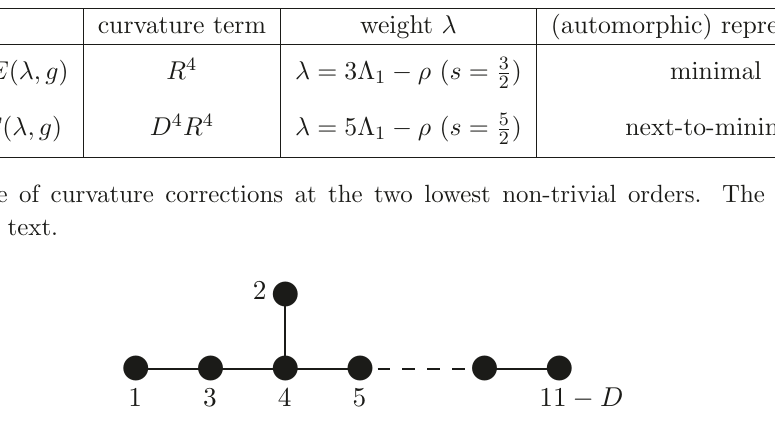
Figure 1 . Dynkin diagram of E 11 − D with (Bourbaki) labelling of nodes used in the